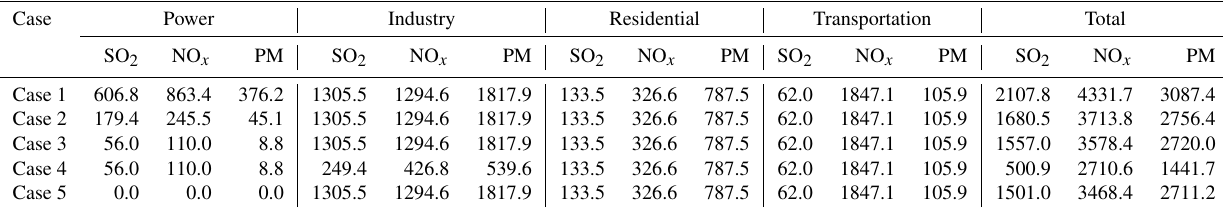
Table 1. The air pollutant emissions by sector for cases 1–5 in the YRD (unit: Gg).